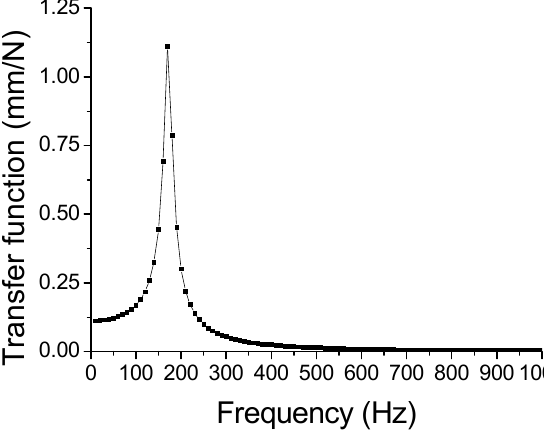
Figure 6. Frequency-based transfer function.